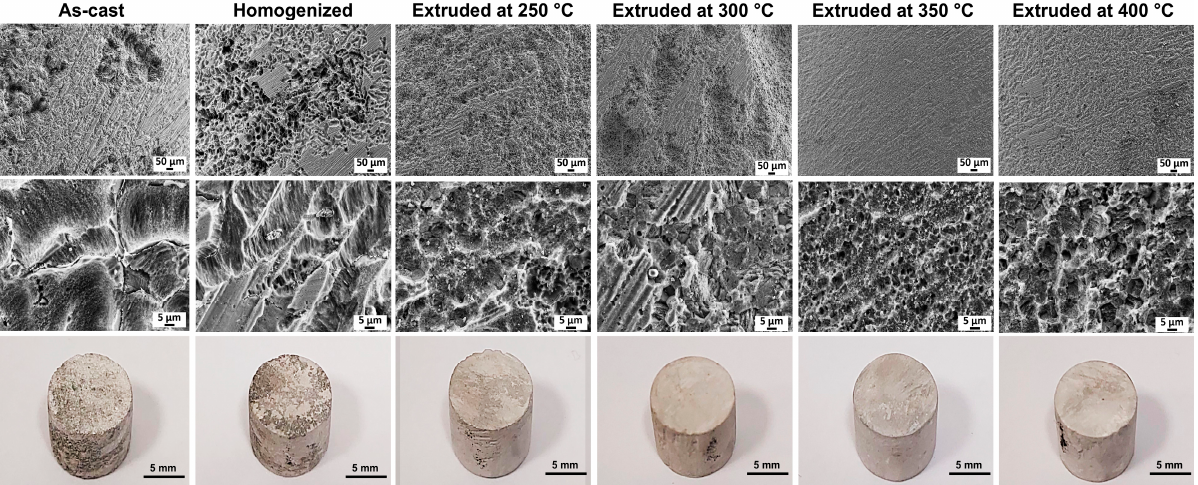
Figure 12. SEM micrographs of the corroded surfaces after 48 h of immersion in 3.5% NaCl with the macroscopic images of the cleaned samples.